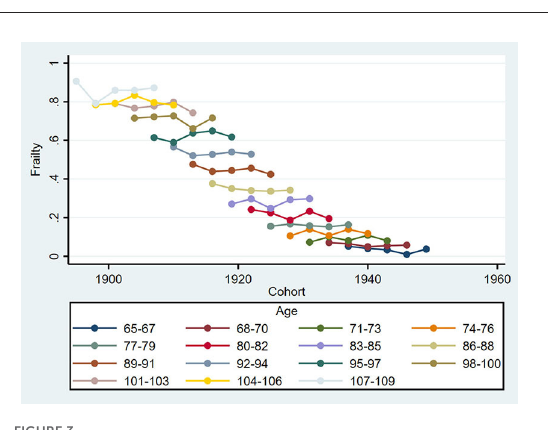
FIGURE3 Frailty rates by birth cohort and age group among Chinese older adults during 2002–2014.